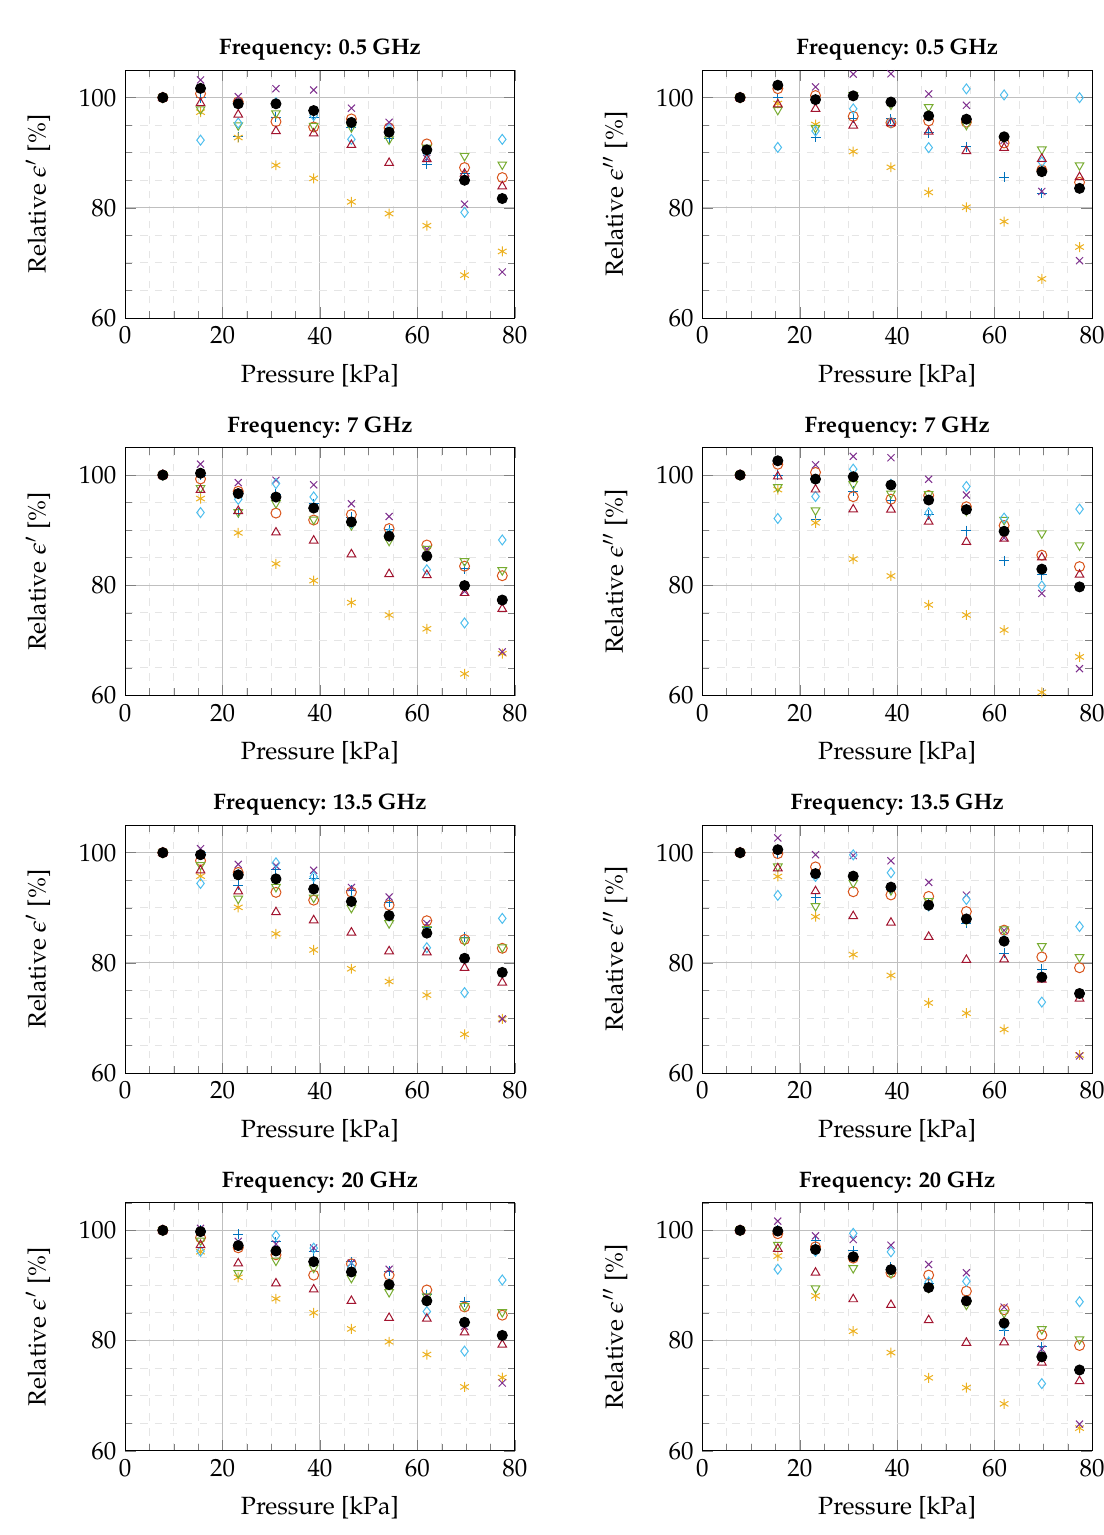
Figure 7. Overview of the relative changes of all conducted experiments as a function of pressure, presented at four linearly spaced frequencies in the measured frequency interval. (Legend: